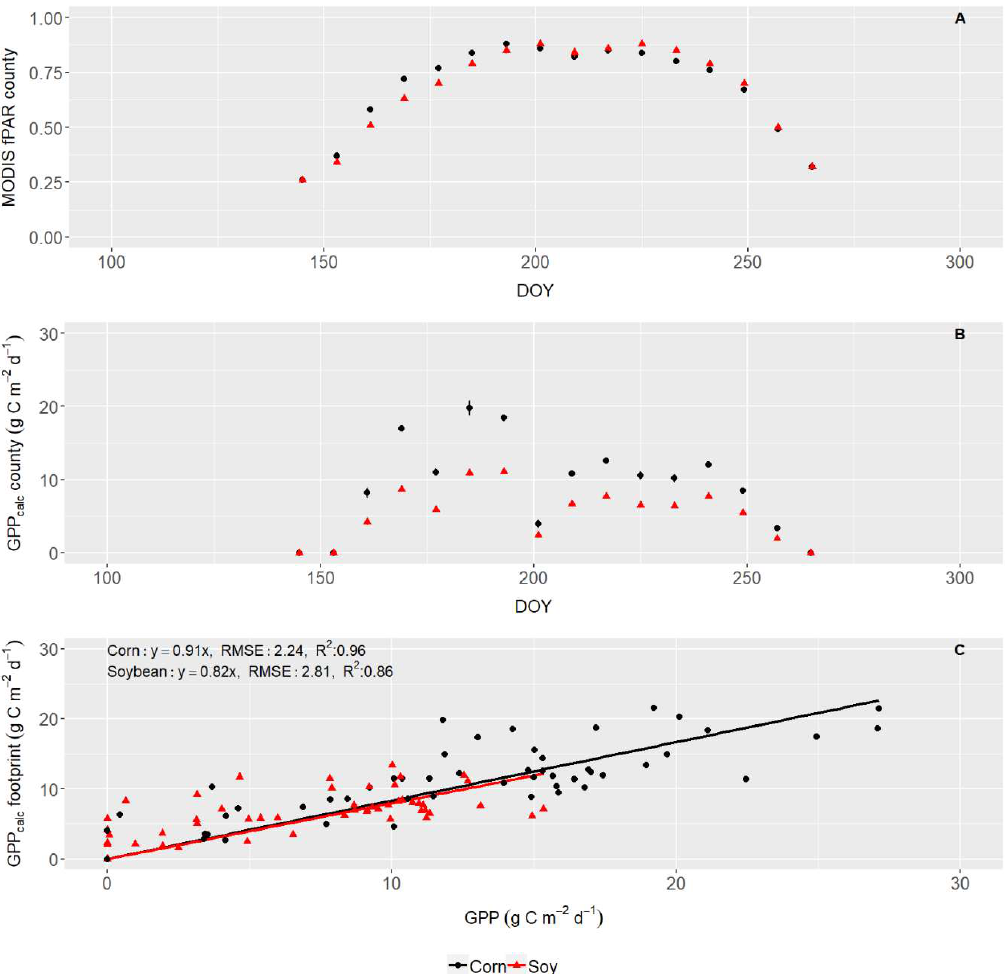
Figure 5. GPP calc as calculated with MODIS fPAR product for corn (black circles) and soybean (red triangles) for 2016: ( A ) median county fPAR, averaged ( ± SE) over county (n = 4), ( B ) daily median county GPP calc (g C M − 2 d − 1 ) averaged over county, and ( C ) linear regression analysis (p < 0.05) with daily EC-derived GPP as independent and 90% footprint GPP calc (g C m − 2 d − 1 ) as dependent variable, R 2 : coe ffi cient of determination, GPP: gross primary production, fPAR: fraction of absorbed photosynthetic active